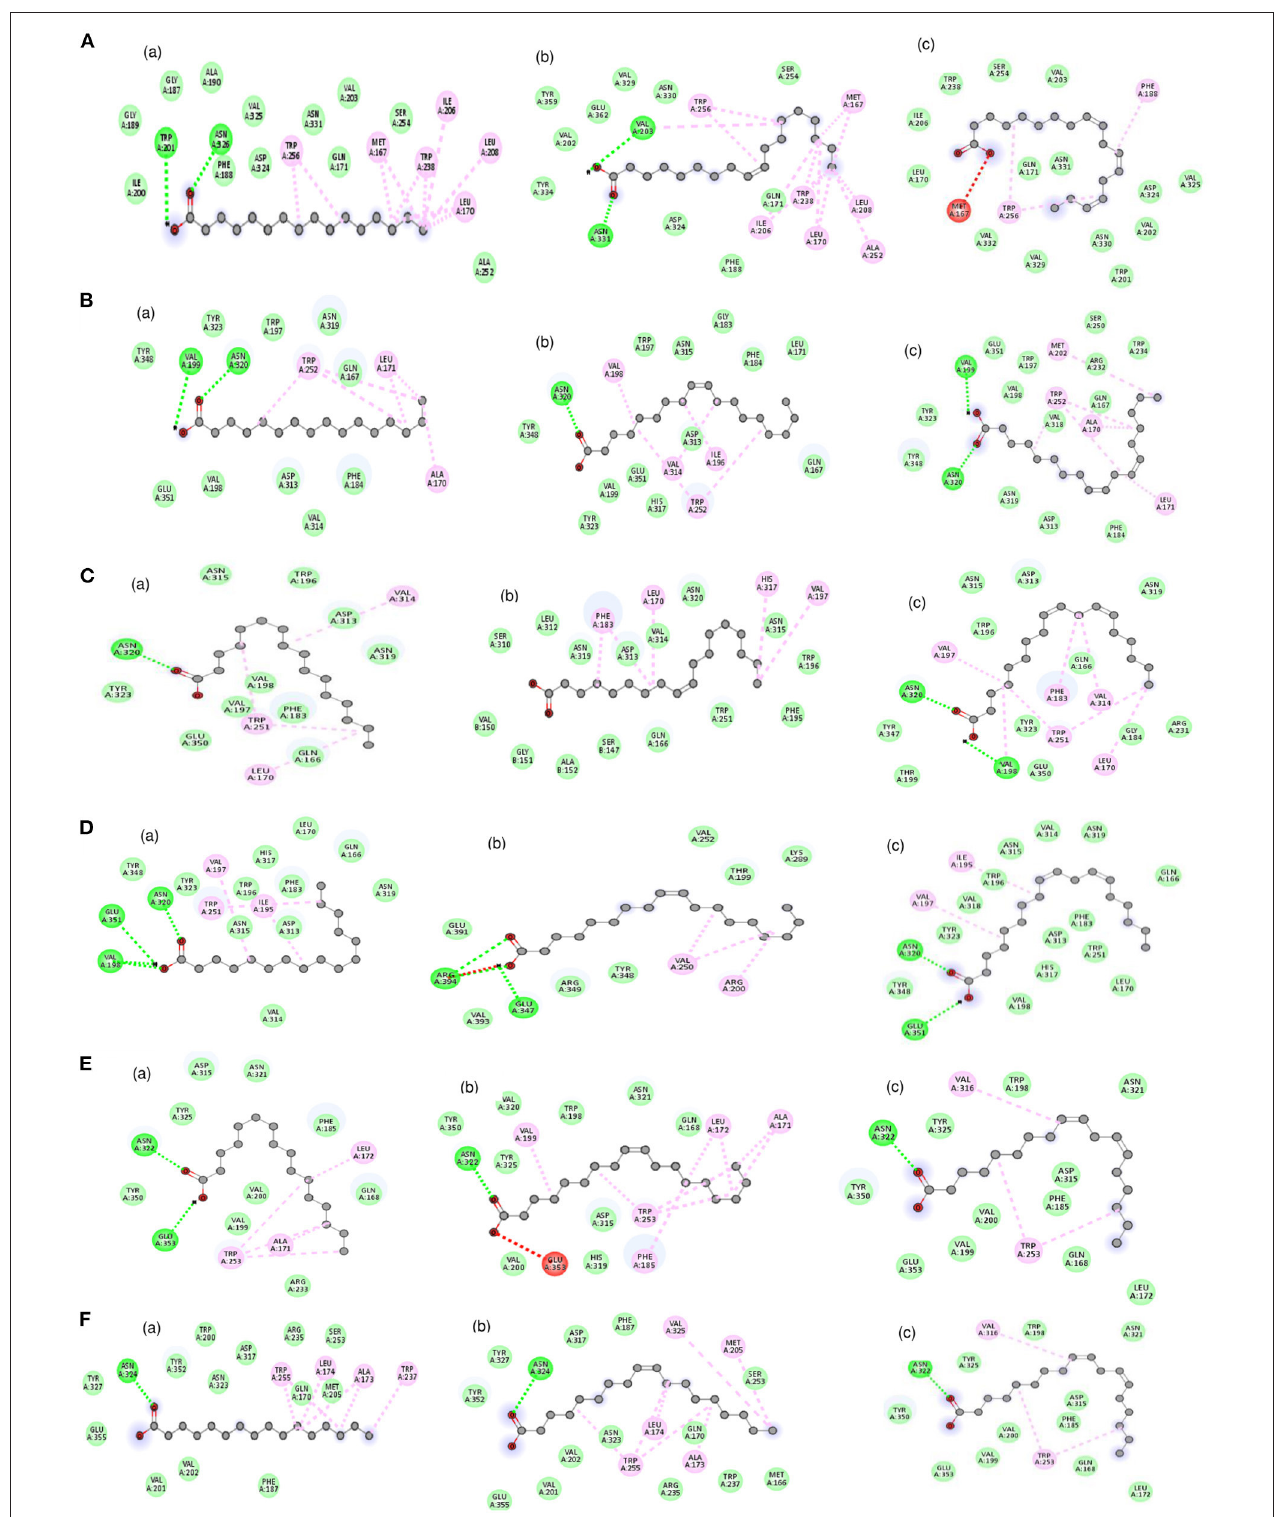
FIGURE 6 | 2D visualization of the interaction between protein and ligands. The various bonds formed between amino acid residues of various proteins with ligands have been depicted. Proteins accessions of (A) Maize B73 protein (NP_001357940.1); (B) Soybean (KRH63043); (C) Sunflower (OTG24573); (D) Arabidopsis (AT1G08510.1); (E) Brassica (A0A078GBF8); (F) Camelina (Csa03g011960.1). Ligands namely (a) Palmitic acid; (b) Oleic acid; (c) Linoleic acid. Bonds in green colour (hydrogen bond); red colour (Unfavorable acceptor-acceptor) and pink colour (Alkyl bond).